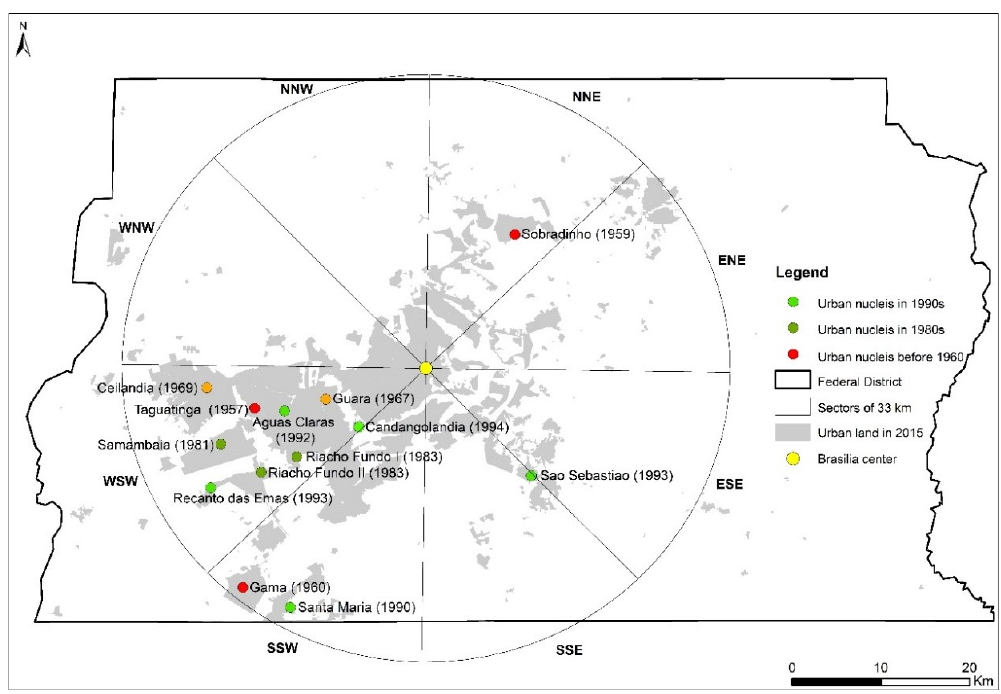
Figure 9. Location of the peripheral urban nucleus around Brasilia created from 1960 to 2015. Source: State Secretariat for Housing and Urban Development of the Federal District (SEDUH-DF).